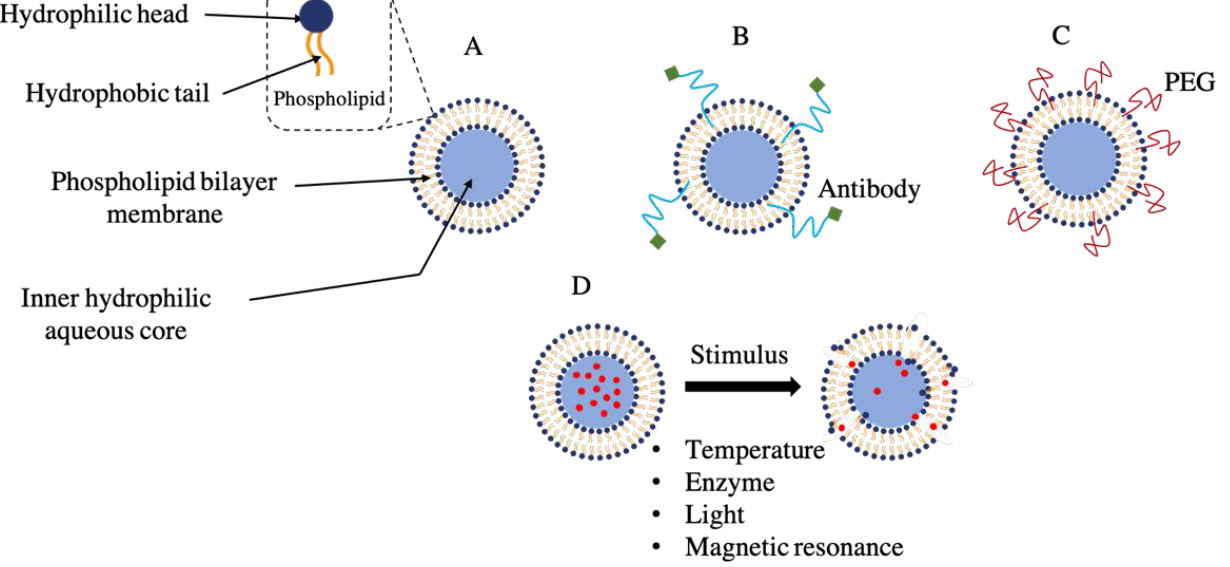
Figure 2. Classification of liposomes based on their composition. ( A ) Conventional liposome, ( B ) pH sensitive liposome, ( C ) long circulating liposome, ( D ) temperature-sensitive, enzyme-sensitive, light-sensitive, and magnetic-response liposomes.